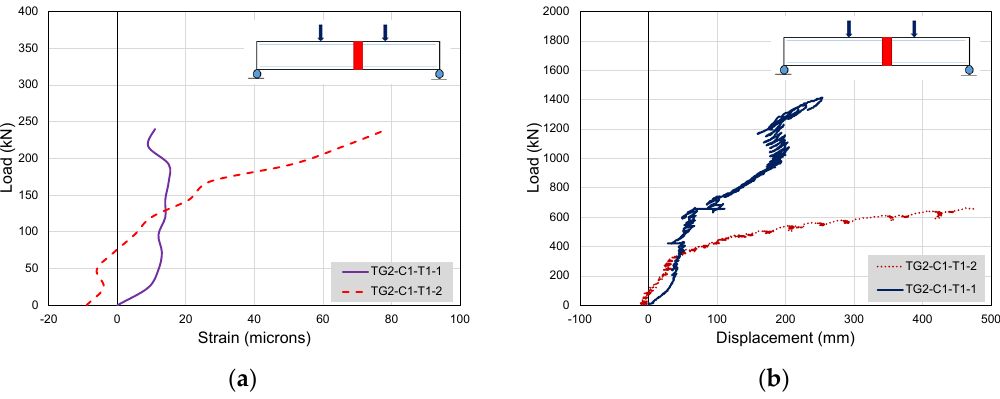
Figure 42. Load versus strain responses at location C1 ( a ) load SP-2-L01 ( b ) load SP-2-L02.